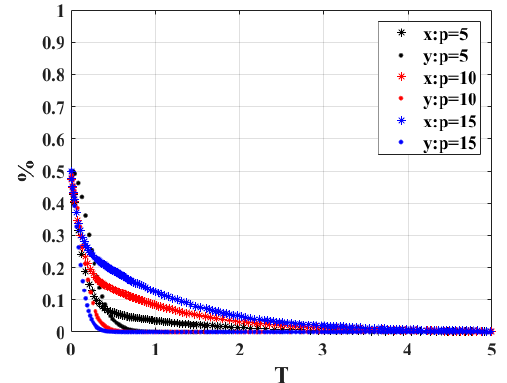
Figure 9. Sensitivity analysis of “ p ”.